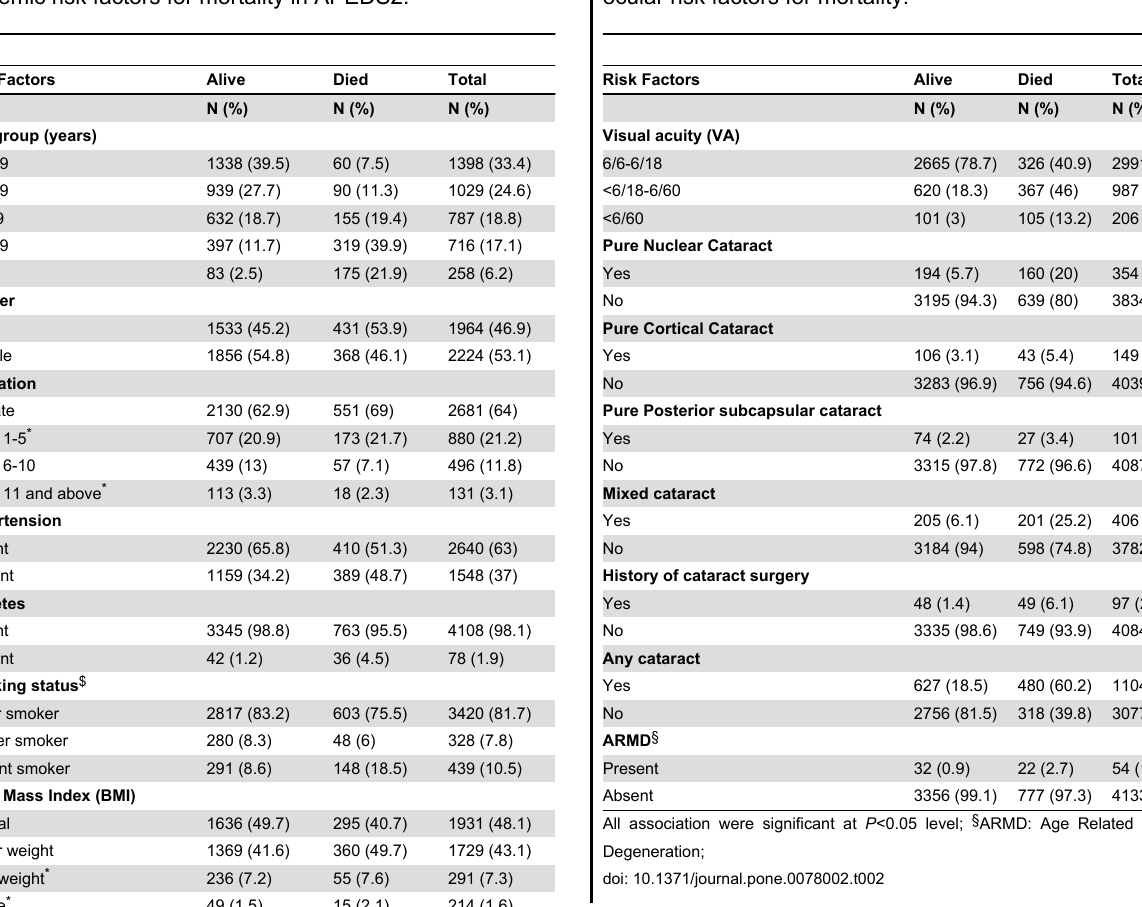
Table 1. Distribution of various demographic, lifestyle and systemic risk factors for mortality in APEDS2.